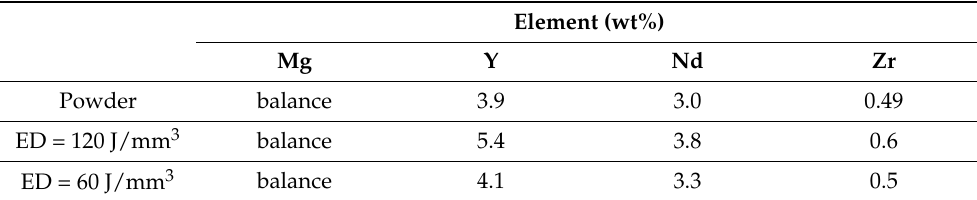
Table 3. Chemical composition of the material processed with 120 J/mm 3 and 60 J/mm 3 as assessed by EDS and compared to the composition given for the